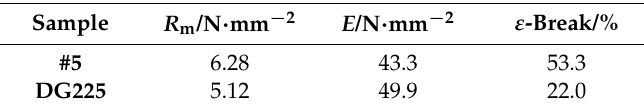
Table 2. Results of tensile strain measurements for the crosslinked PEM #5 and the polymer membrane